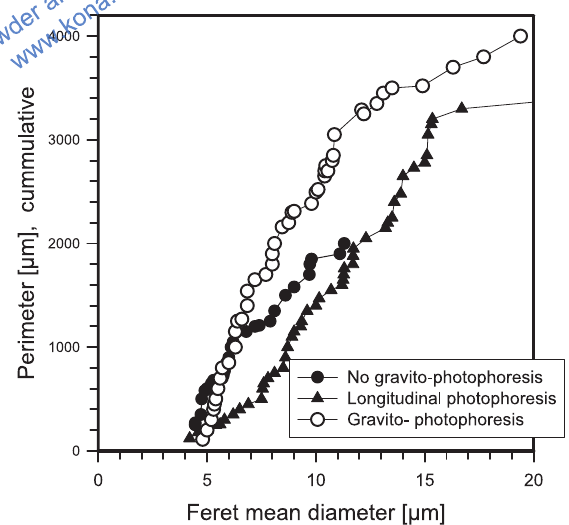
Fig. 18 Relation between the Feret diameter and perimeter of particles. The particles showing gravito-photophoresis have the largest perimeter, i.e. are the most irregular (Jovanović,